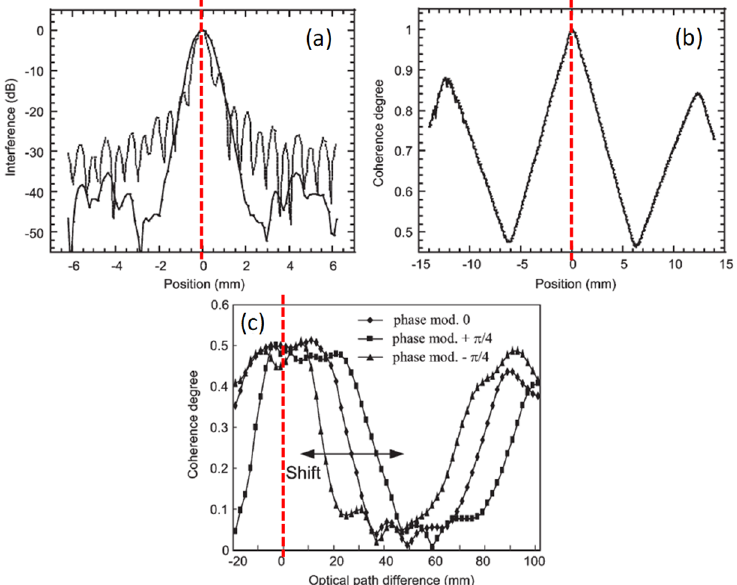
Figure 8. Examples of a variety of shapes of synthesized optical coherence functions [22]. ( a ) A delta function-like optical coherence function with side lobes reduced using intensity modulation; ( b ) triangle-shaped optical coherence function; and ( c ) trapezoid-shaped optical coherence function.